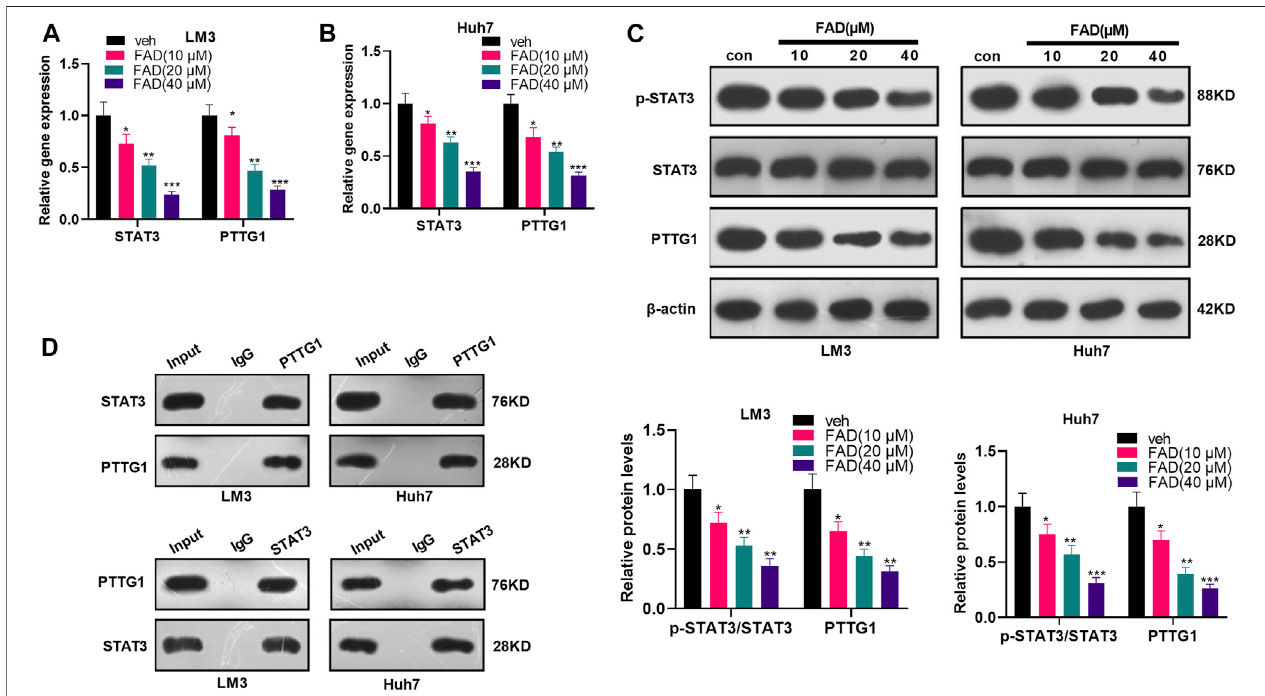
FIGURE 4 | FAD inhibited the STAT3/PTTG1 expression. HCC cell lines (Huh7 and LM3) were treated with FAD (10, 20, and 40 µM) for 24 h. (A, B) . The STAT3/ PTTG1 level was monitored by qRT-PCR. (C) . The STAT3/PTTG1 pro fi le was determined by the WB. (D) . IP experiment was applied to clarify the binding association between STAT3 and PTTG1. * p < 0.05, ** p < 0.01, *** p < 0.001 (vs. veh group). N (cid:2)